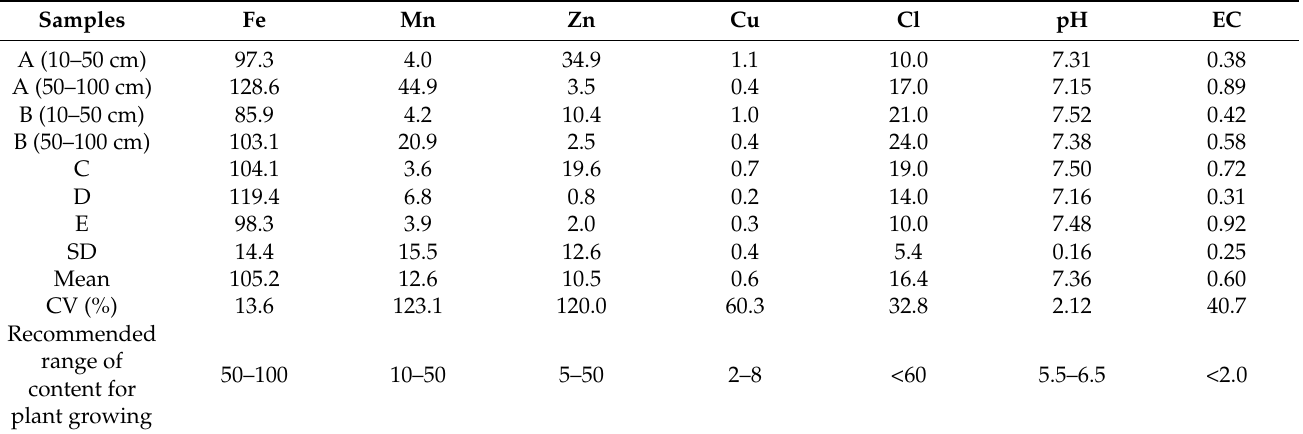
Table 4. Micronutrients (mg · dm − 3 ), pH reaction (in H 2 O) and EC (mS · cm − 1 ) in samples collected at selected